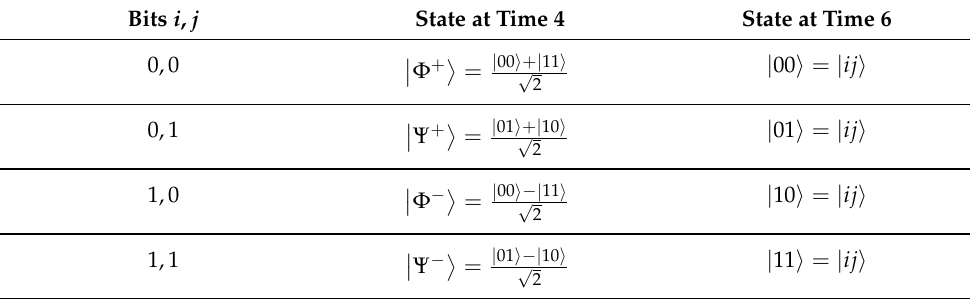
Table 1. The Schrödinger state in relation to the bits to transmit. Bits i , j State at Time 4 State at Time 6